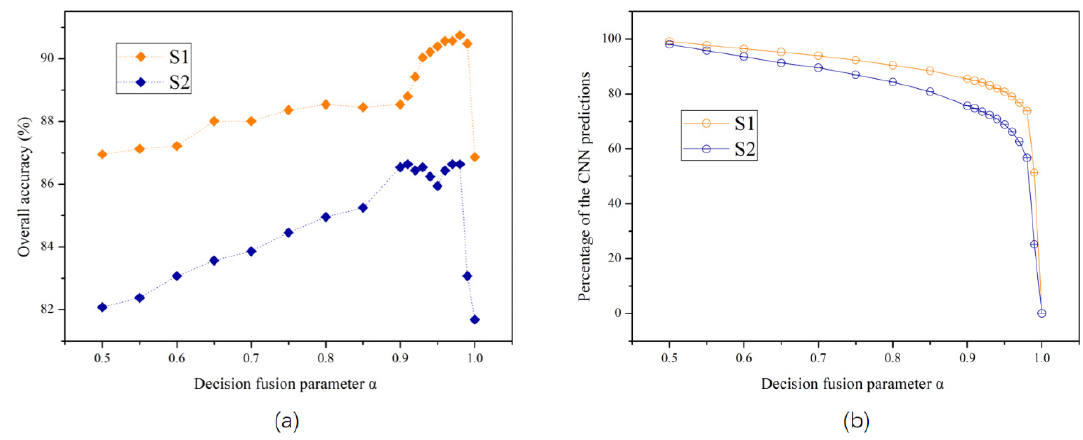
Figure 8. ( a ) Variation in classification accuracy and ( b ) area percentage of the CNN predictions in the fused output, plotted against α .